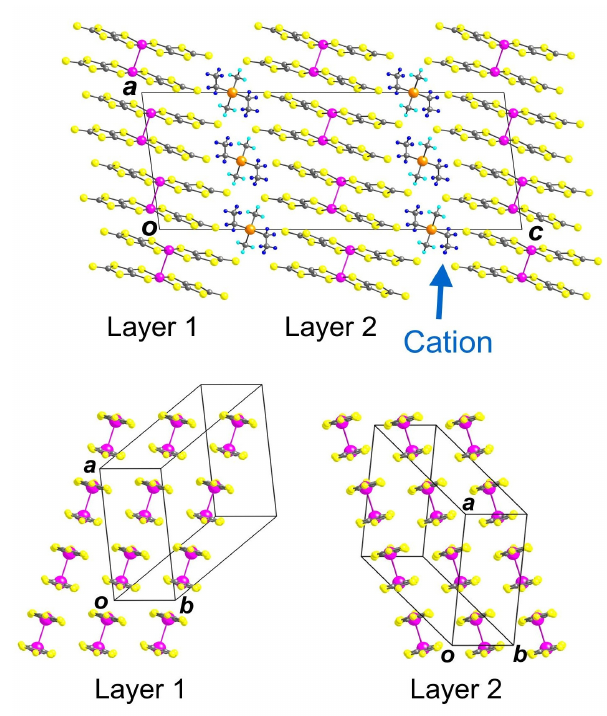
Figure 2. Crystal structure of the β '-type Pd(dmit)